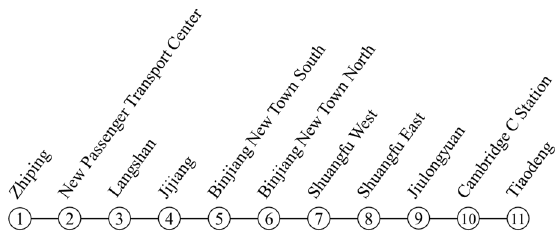
Figure 5. Map of the Jiangjin Line.